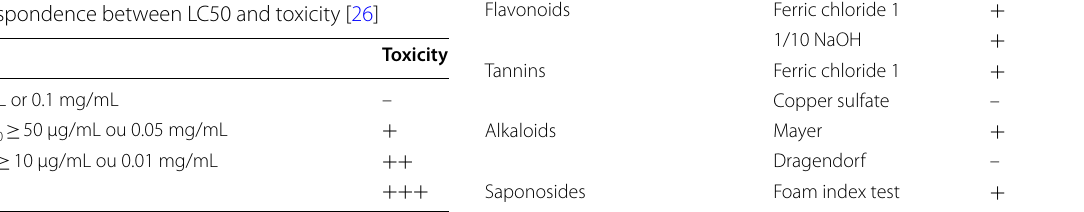
: moderate toxicity; ++